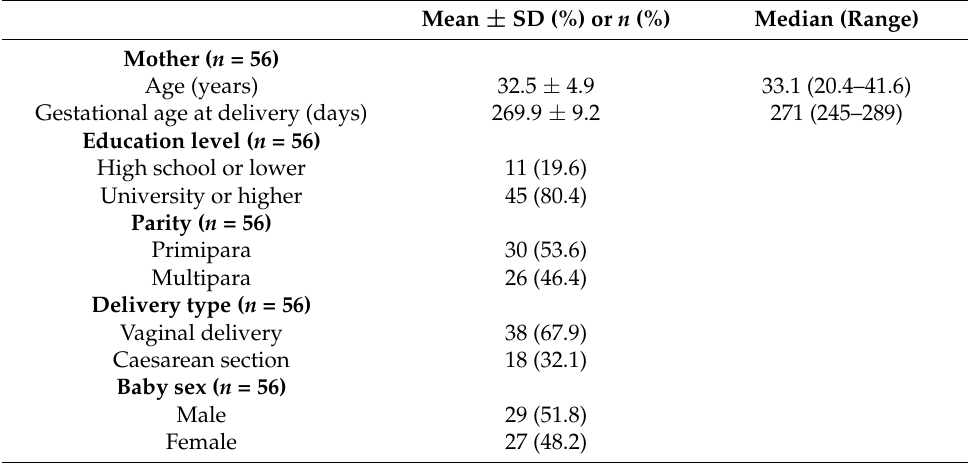
Table 1. Characteristics of the study